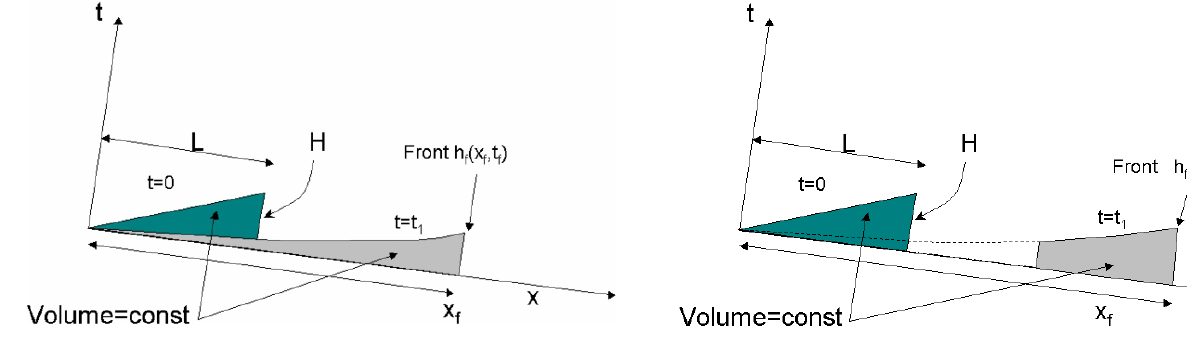
Fig. 1. Scheme of kinematic wave, as proposed by Arattano and Savage (1994). Figure 2. Scheme of kinematic wave, as proposed by Eq(s).(12 - 13). 2